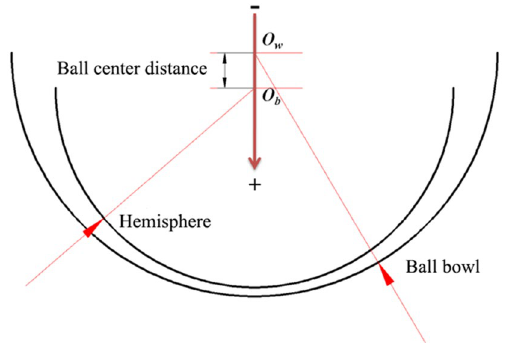
Figure 2. Diagram of ball center